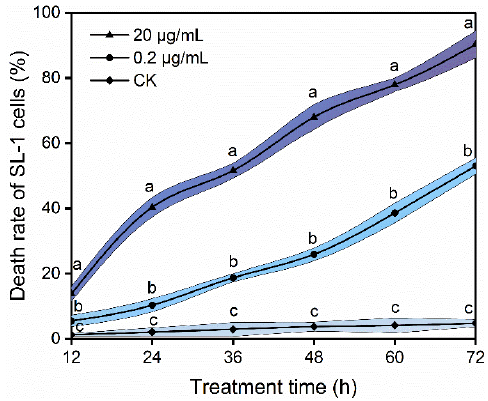
Figure 2. Toxicity of rotenone at 20 µg/mL and 0.2 µg/mL to SL-1 cells over 72 h. Data are presented as mean ± S.E ( n = 3). Different letters at each observation time point indicate significant differences in the death rate of SL-1 cells among treatments at p < 0.05 level based on Tukey’s HSD